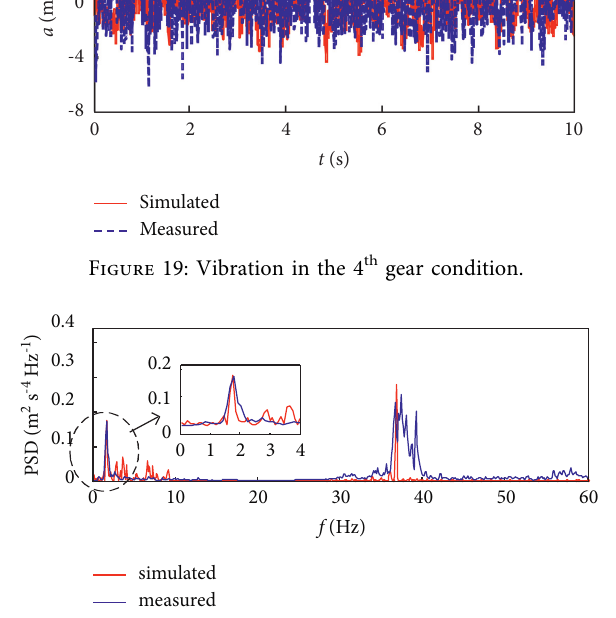
Figure 20: PSD of acceleration in the 3rd gear condition.